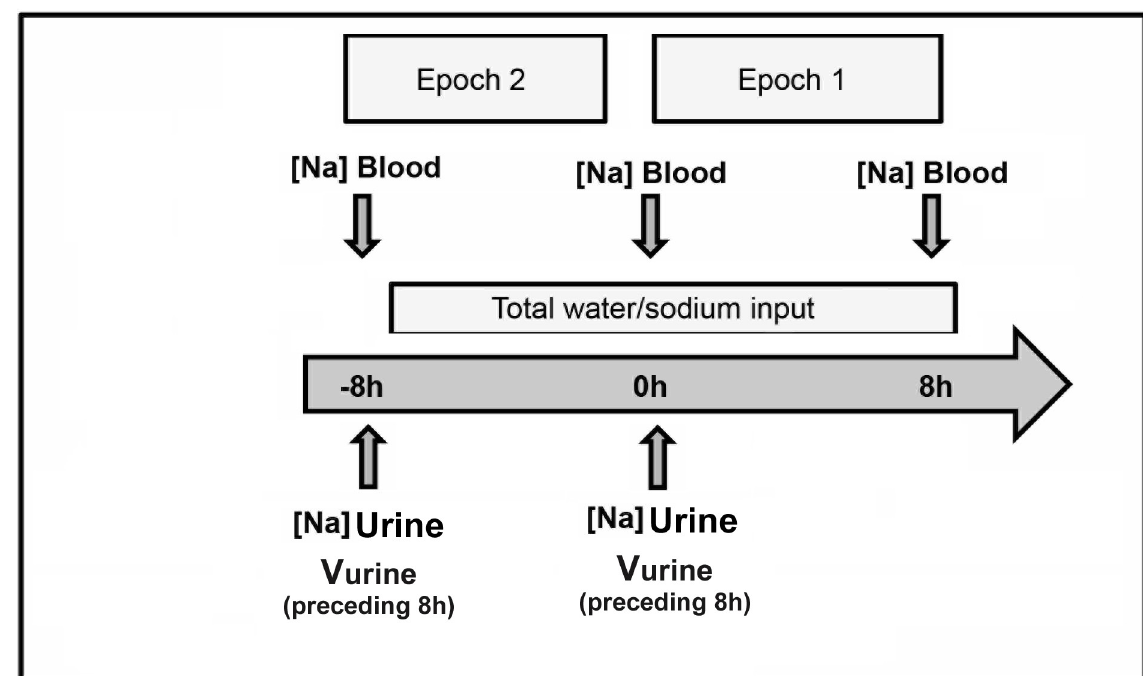
Fig 1. Representative schema of study